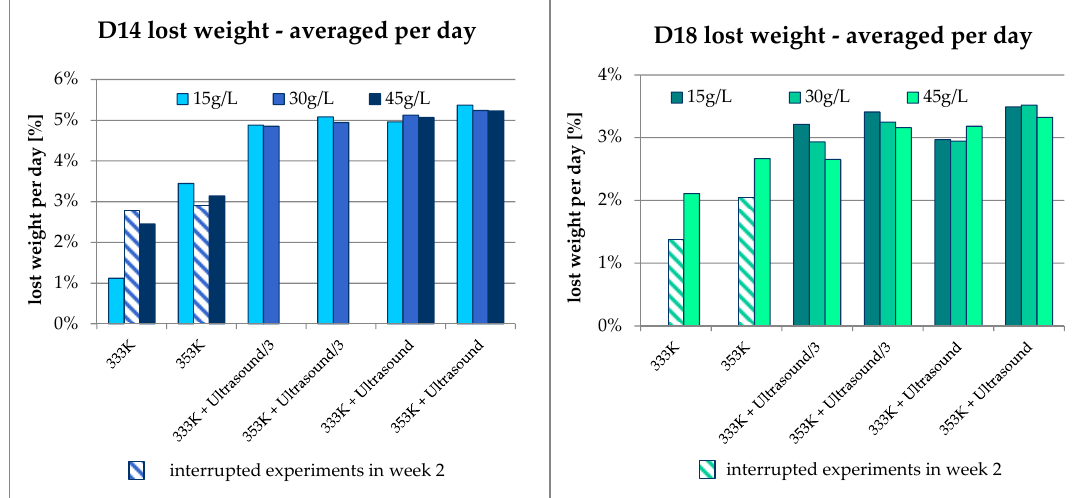
Figure 11. Lost weight for different PCD samples averaged per day. 35 kHz ultrasound varied from “none”, “ultrasound on” for a third of the run time, to “full-time ultrasound”, as shown from left to right.